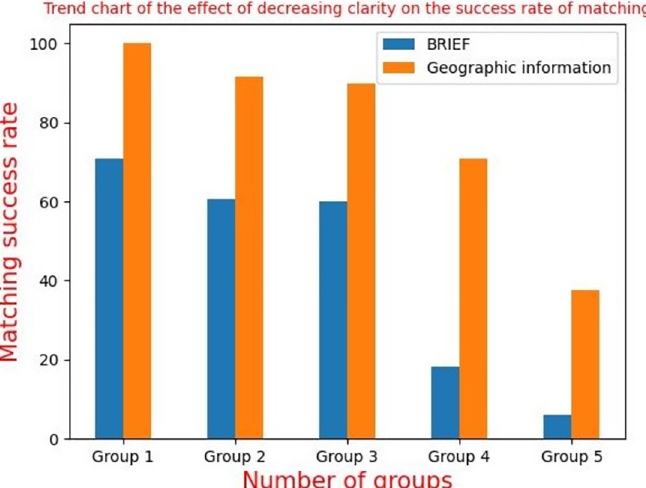
Fig 10. Trend chart of matching success rate of sharpness reduction